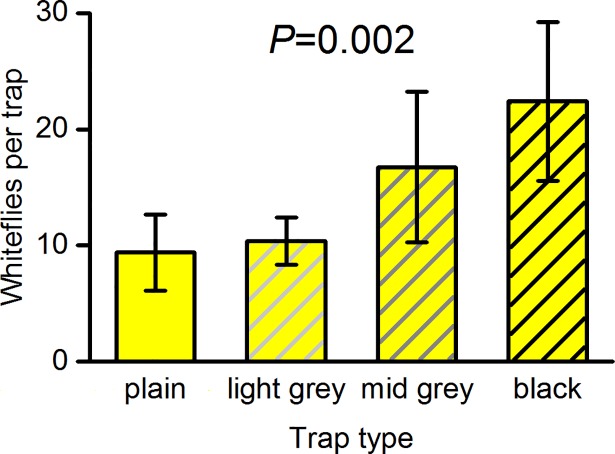
Effects of patterns with increasing shades of grey on the number of whiteflies caught on yellow sticky board traps.Mean catch on the pattern side and corresponding side of plain (control) traps ± SE in experiment F (n = 20). The significance is from a regression of log-transformed trap catch on darkness of grey/black.